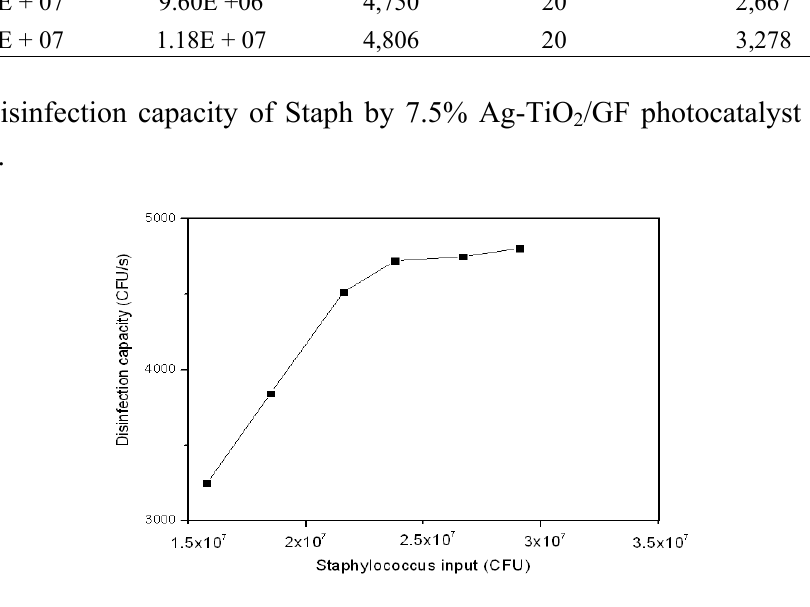
/GF photocatalyst at different 2